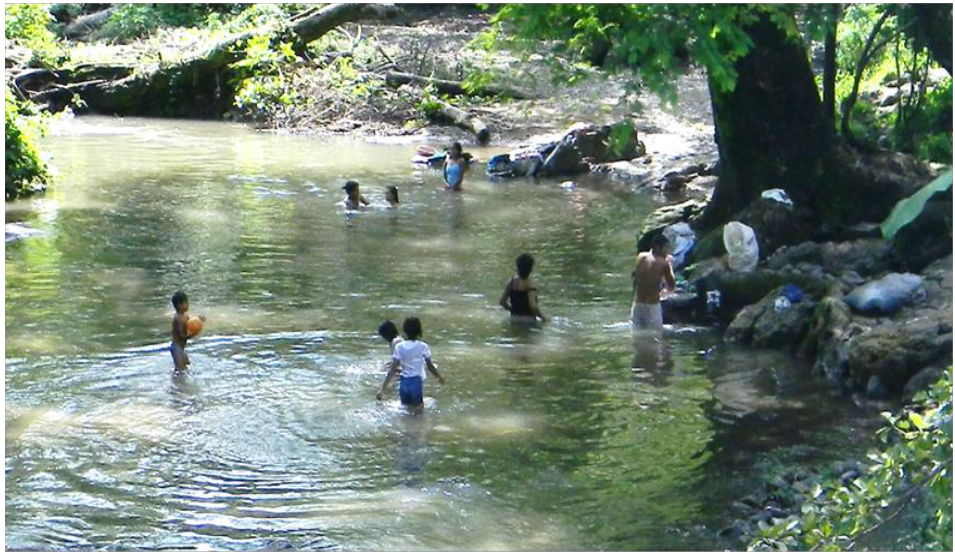
Figure 5. The use of rivers or creeks for different purposes in low-income rural areas in Nicaragua.